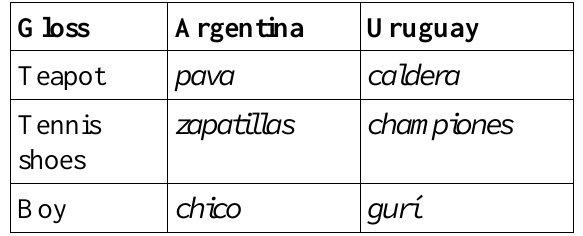
Table 1. Some lexical differences between Argentina and